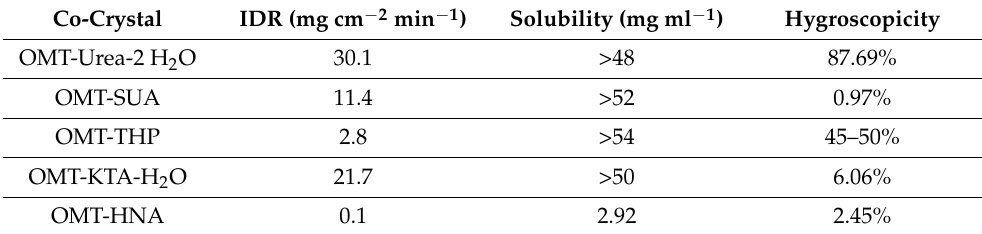
Table 4. Co-crystals of oxymatrine showing the IDR, solubility, and hygroscopicity data (reprinted with permission from